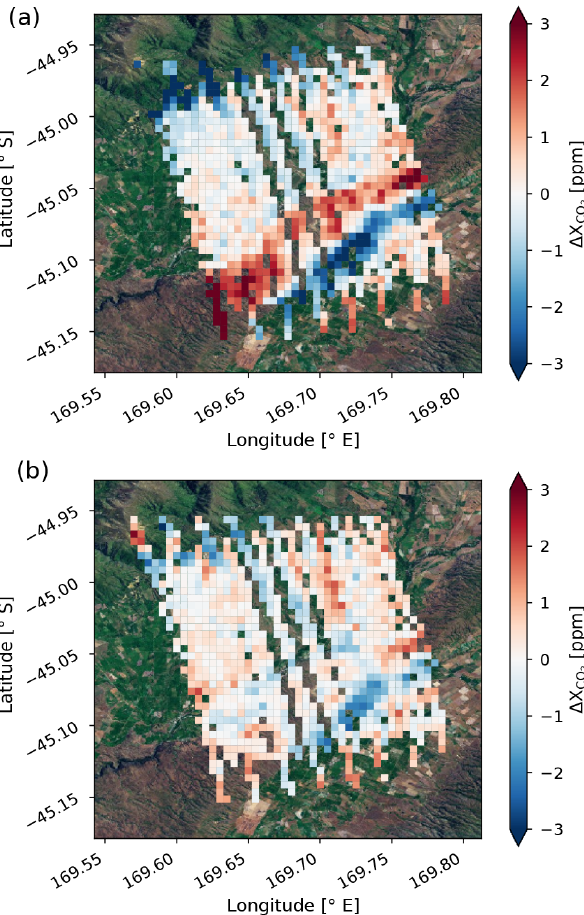
Figure 13. v8 (a) and v9 (b) bias-corrected X CO New Zealand, on 17 February 2015. (cid:49) X CO way as in Fig. 1. Data are aggregated into 0.005 ◦ × 0.005 ◦ latitude– longitude square